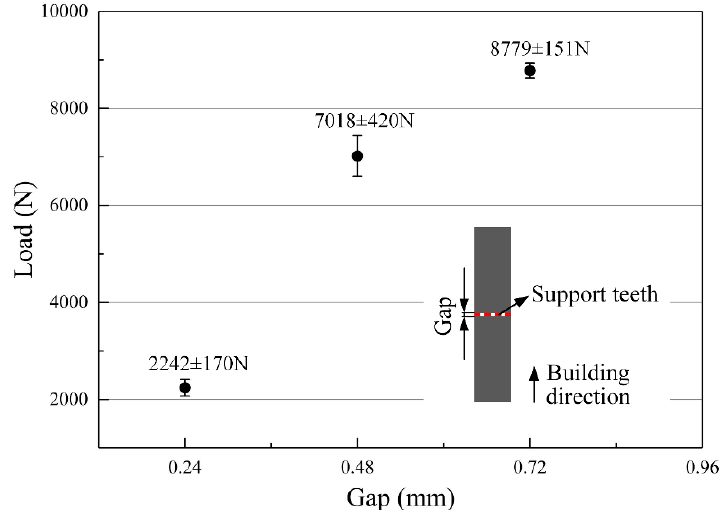
Figure 9. Tensile test results of samples with different gaps.